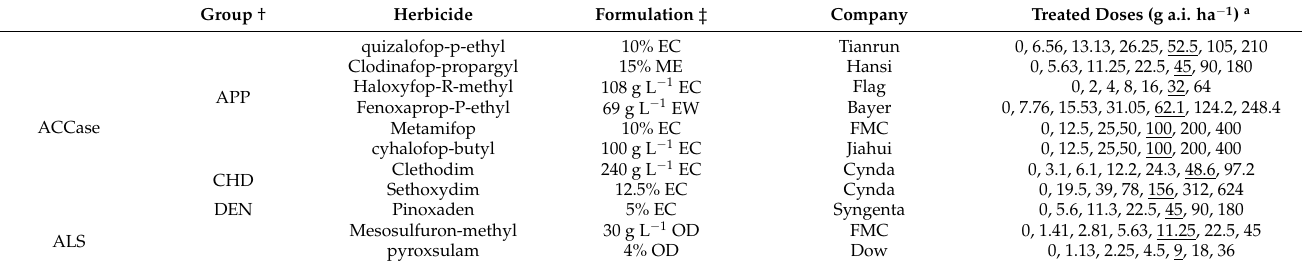
Table 3. Dose-response to acetyl-CoA carboxylase inhibitors and acetolactate synthase